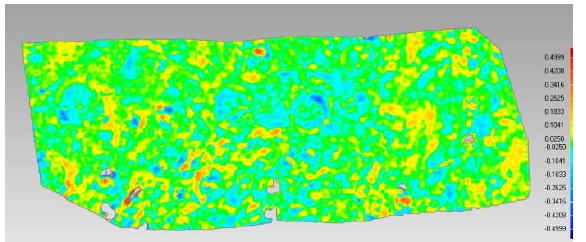
Figure 9. Colour coded error map of the Concrete sample DTM for 10° (top) and 50° (bottom) illumination angle